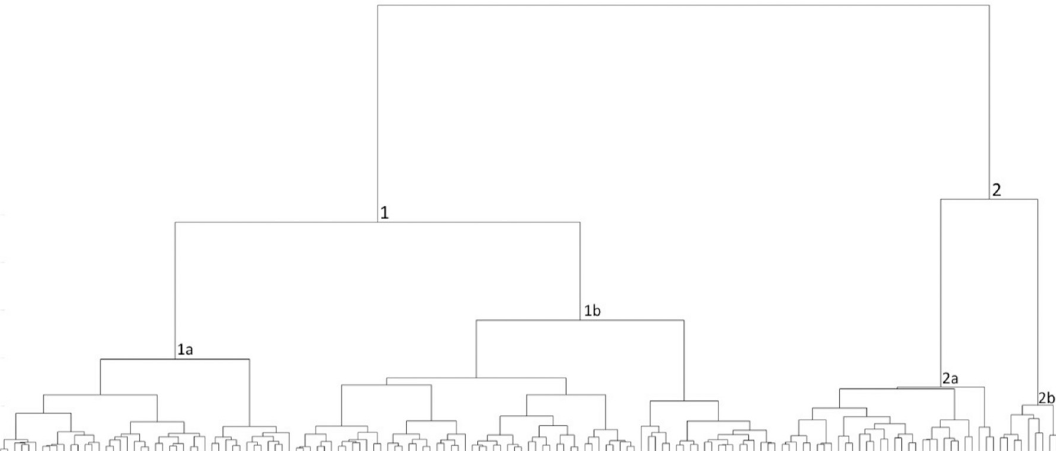
Fig 3. Cluster tree for the IBA 150 storage-jars. The lines at the base represent one item in the assemblage, and each branch represents a segregated morphological group (type variation) based on similarity.